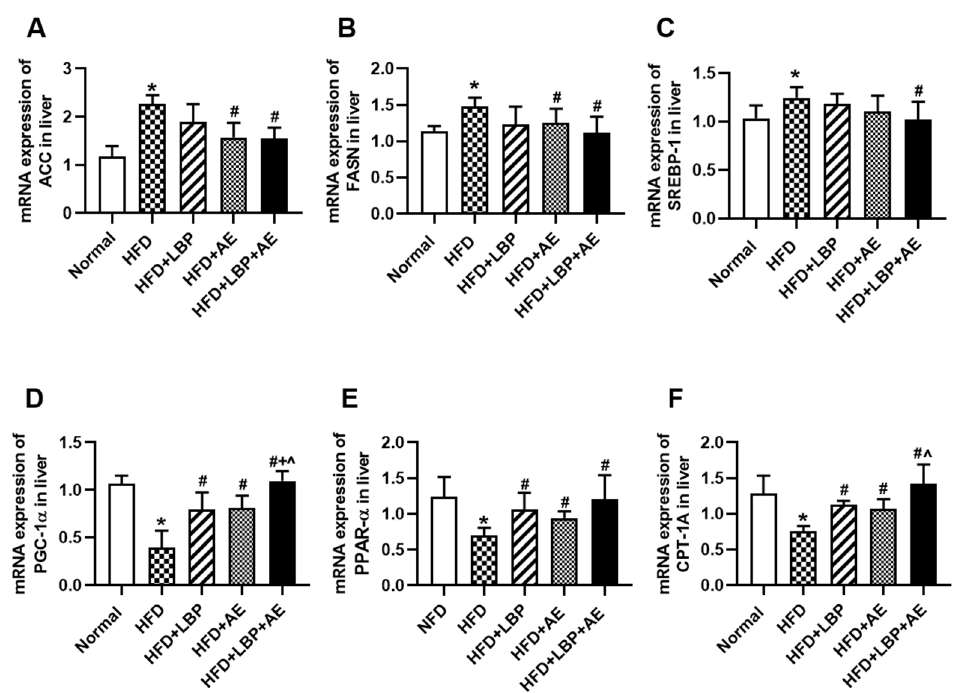
Figure 4. LBP plus AE affected hepatic fatty acid synthesis and oxidation. ( A ) mRNA expression of ACC in liver. ( B ) mRNA expression of FASN in liver. ( C ) mRNA expression of SREBP1c in liver. ( D ) mRNA expression of PGC-1 α in liver. ( E ) mRNA expression of PPAR α in liver. ( F ) mRNA expression of CPT-1A in liver. * p < 0.05 vs. the NFD group. # p < 0.05 vs. the HFD group. + p < 0.05 vs. the HFD plus LBP group. ^ p < 0.05 vs. the HFD plus AE group.